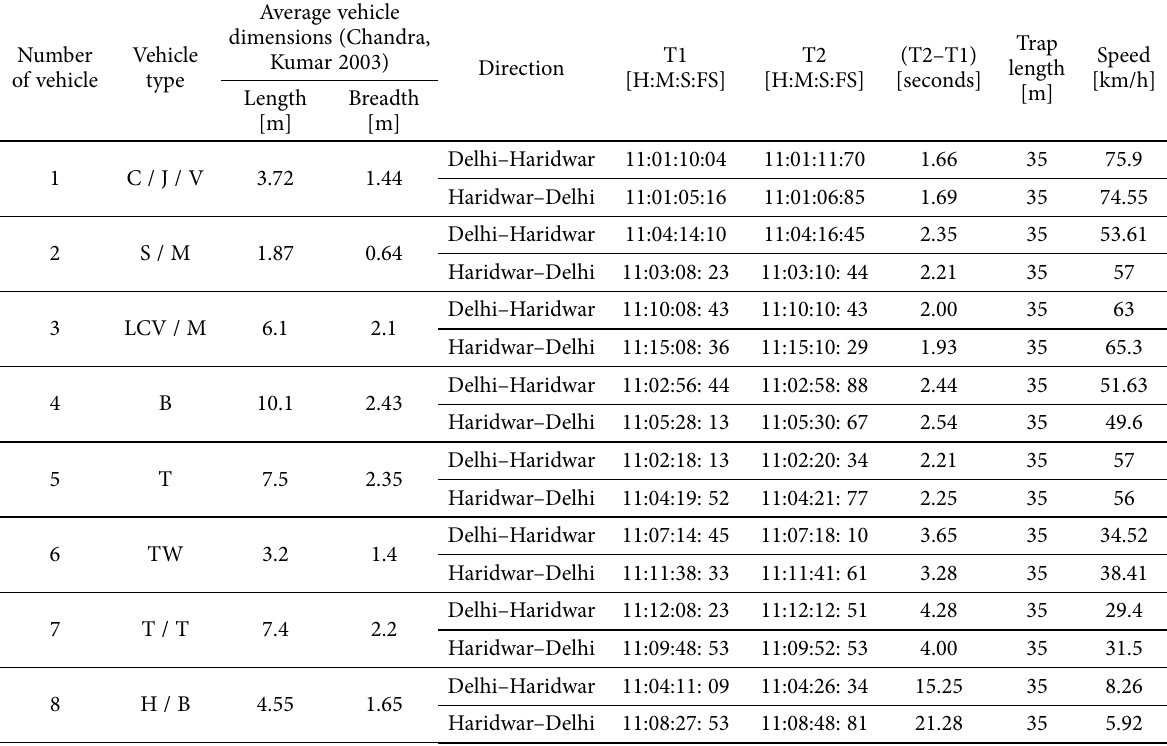
Table 2. Data set processing